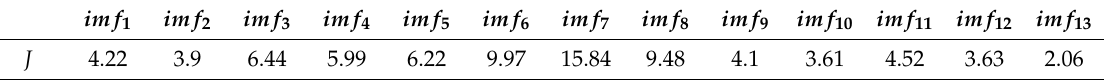
Table 1. Fisher discrimination function values of MNPE features of imf 1 – imf 13 .